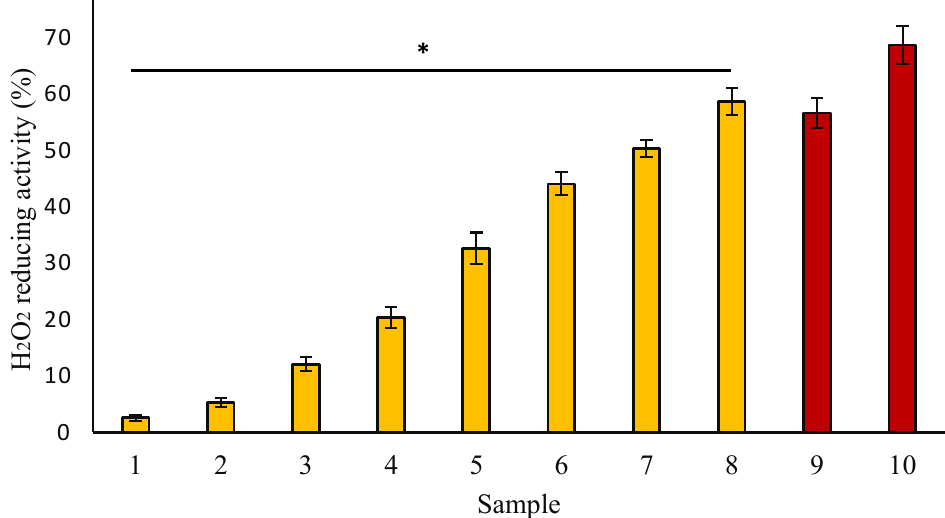
Figure 1. H 2 O 2 reducing ability (%) of myrrh methanolic extract. Samples 1 to 8 (yellow bar) correspond to various concentrations of extract (50, 75, 100, 200, 300, 400, 500, and 600 µ g/mL). Samples 9 and 10 (red bar) correspond to samples having 100 and 200 µ g/mL concentrations of ascorbic acid. The data are shown as means ± standard error of the means (n = 3, p < 0.05). The statistical differences are represented with an asterisk (*) for myrrh denoting significance at p < 0.05 in comparison with the reference sample.